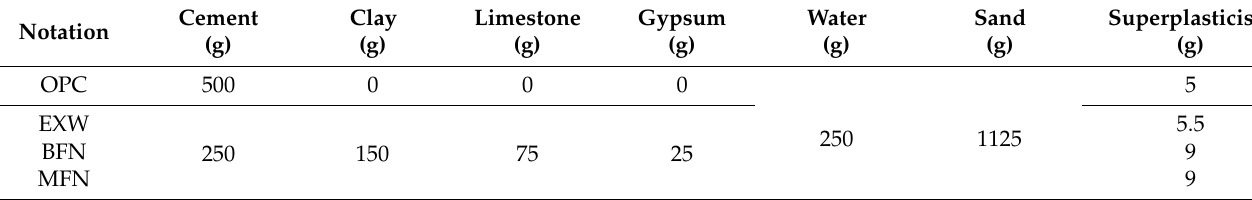
Table 2. Mix constituents of the